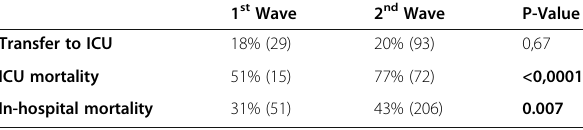
Table 2 (abstract A103). Number of patients admitted to ICU and mortality rate 1 st Wave 2 nd